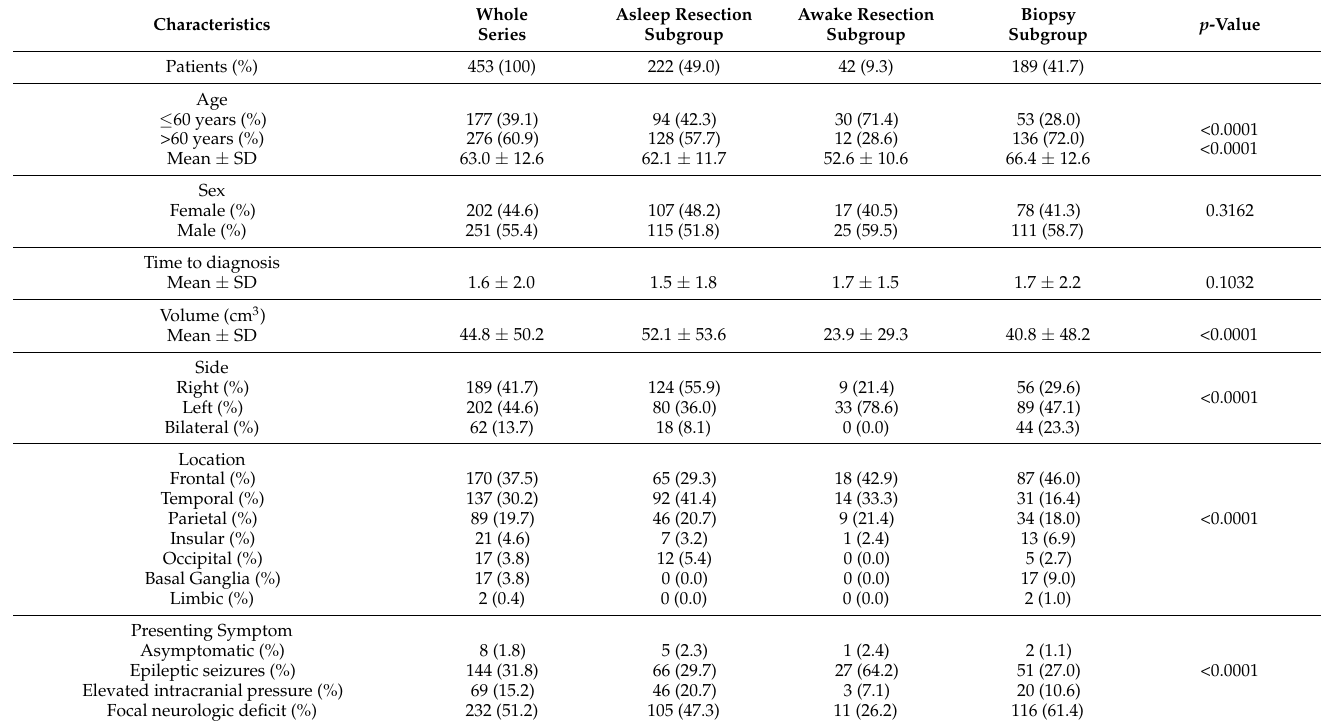
Table 2. Patient and tumor characteristics ( n =